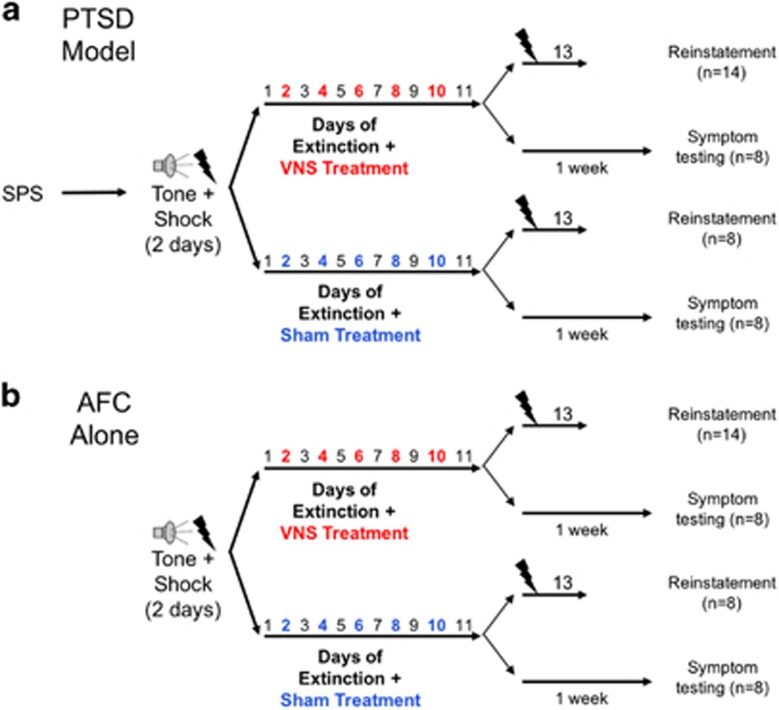
Timeline for extinction, reinstatement and behavioral assays. (a) Protocol for PTSD model rats. Rats underwent the SPS procedure followed by 2 days of AFC and 11 days of extinction, five were paired with VNS (red) or sham stimulation (blue) on alternate (even) days. Freezing in the presence of the CS was used as a measure of conditioned fear. Conditioned fear was measured on the odd days that fell between VNS or sham stimulation days. Following extinction, some rats underwent a reinstatement trial where they received one unsignaled footshock. The day after the footshock, these rats were given another day of extinction to measure conditioned fear. The remaining rats were tested on a battery of behaviors to measure PTSD symptoms 1 week after the end of extinction. The order of the tests was counterbalanced. (b) Protocol for AFC alone rats. Rats in the AFC alone group were treated exactly like PTSD model rats; however, the AFC alone group did not undergo the SPS procedure. AFC, auditory fear conditioning; PTSD, post-traumatic stress disorder; SPS, single prolonged stress; VNS, vagus nerve stimulation.